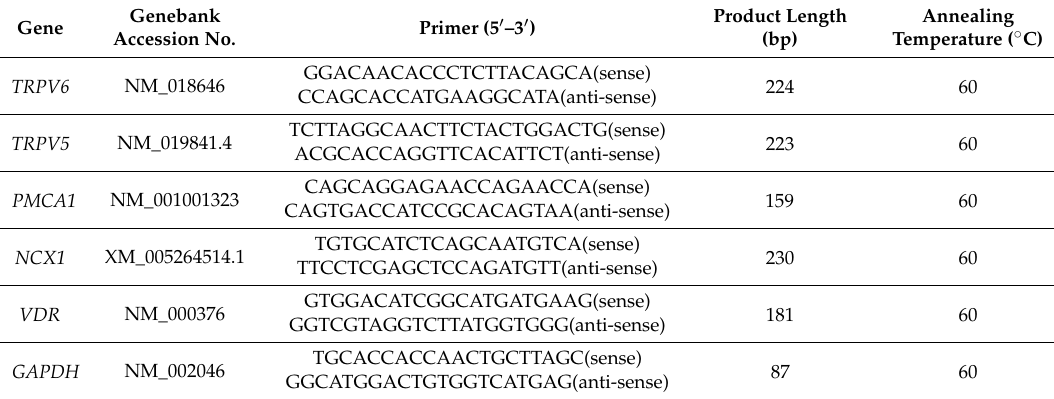
Table 1. Real-time primer sequences utilized in this